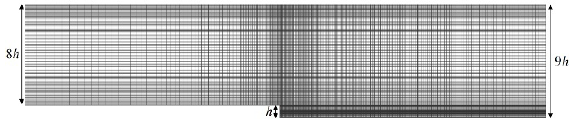
Figure 1. Detail of Backward-facing step mesh. All spatial dimensions were normalized by the step height, h .